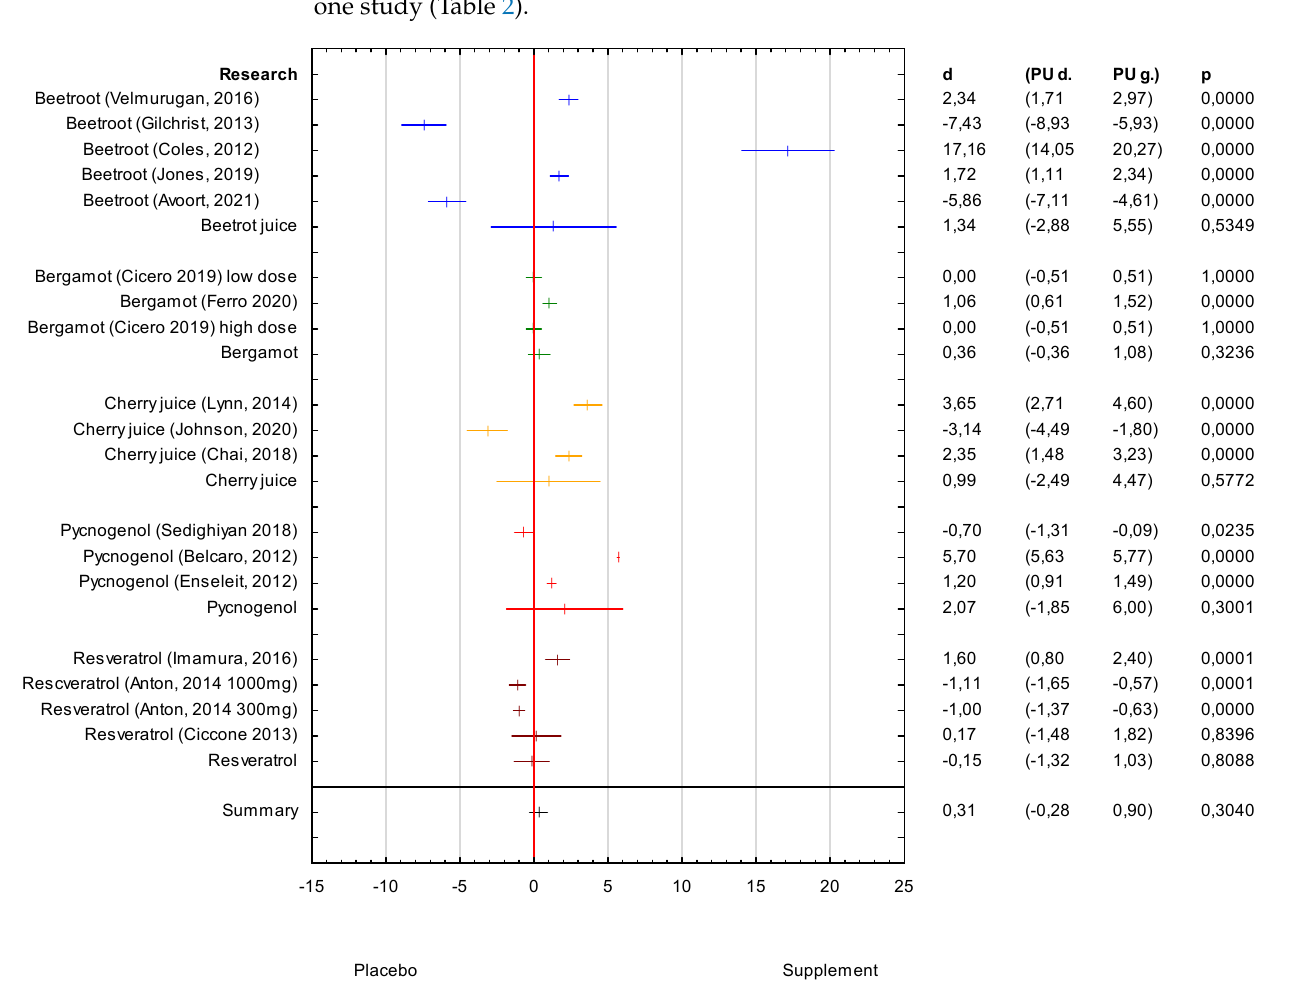
Figure 3. Forest plot of the results of the meta-analysis for supplement effectiveness on DBP versus the placebo group. Data are shown as mean effect sizes with 95% CI.